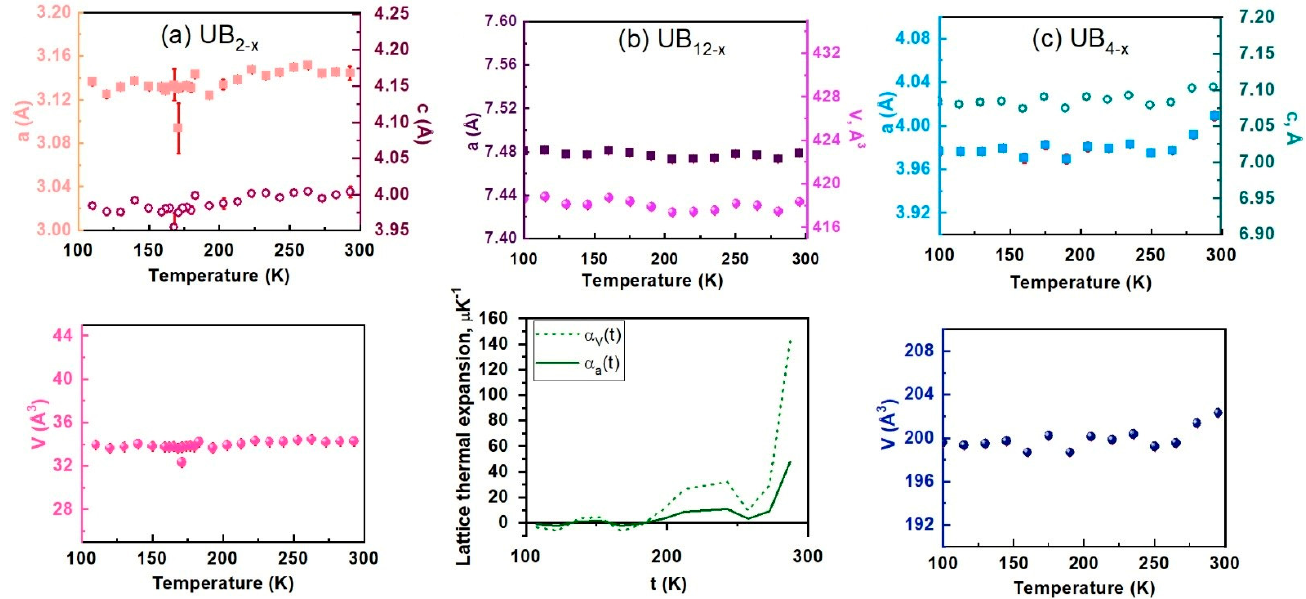
Figure 2. Lattice parameters and volume expansion of ( a ) UB 2 − x , ( b ) UB 4 − x , and ( c ) UB 12 − x in the temperature range (100–300) K. For UB 12 − x , the lattice thermal expansion is also presented. Table 4. Linear fit of the lattice parameters and volumes with the temperature.